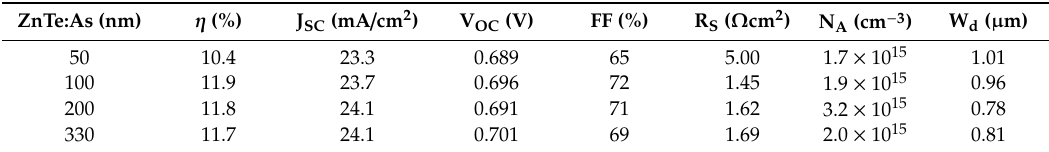
Table 2. PV parameter summary of CdTe thin film solar cells with different ZnTe:As back contact layer thicknesses.